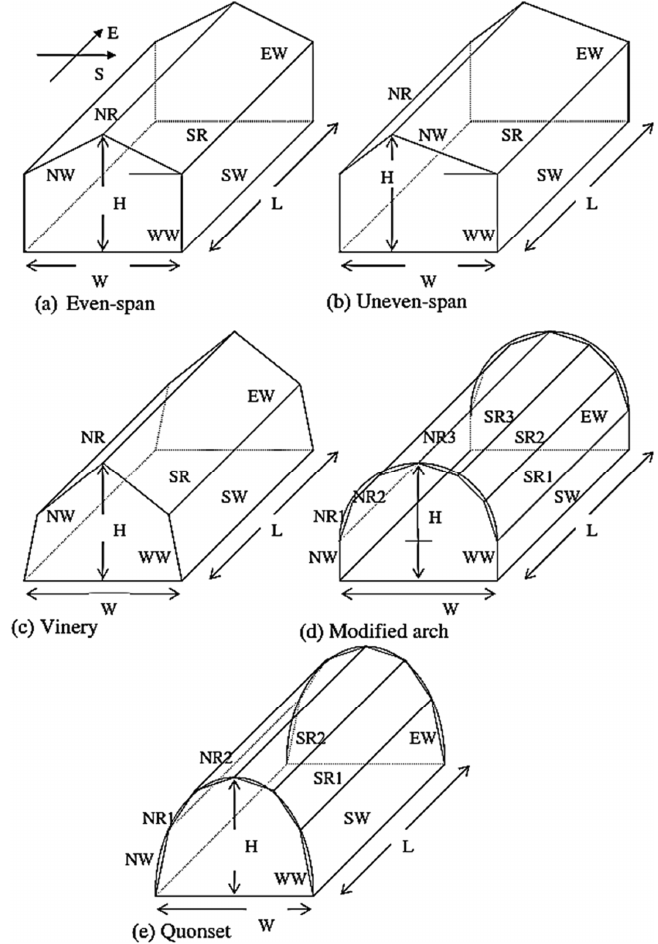
Figure 18. View of several greenhouse shapes. Reproduced with permission from V. P. Sethi, Solar Energy Journal, published by Elsevier, 2009 [316]. Energy Journal, published by Elsevier, 2009